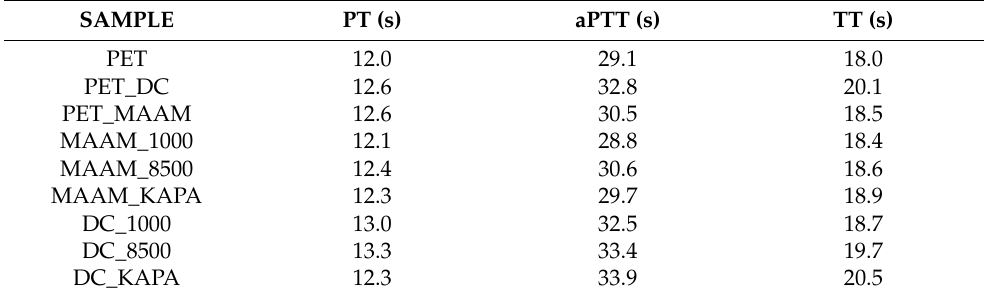
Table 4. Anticoagulation activity results; PT: prothrombin time; aPTT: activated partial thromboplas- tin time; TT: thrombin